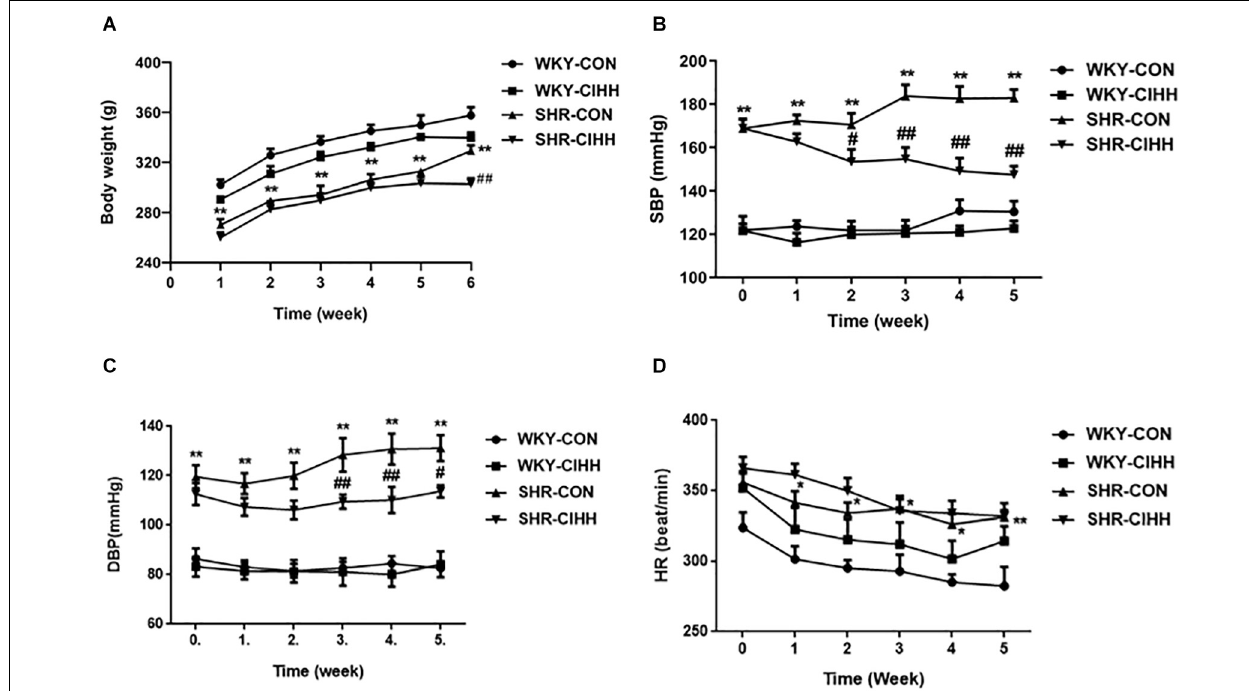
FIGURE 1 | Effect of chronic intermittent hypobaric hypoxia (CIHH) on body weight and arterial blood pressure in spontaneously hypertensive rat (SHR). (A) Body weight; (B) systolic blood pressure (SBP); (C) diastolic blood pressure (DBP); (D) heart rate (HR). Data are expressed as mean ± SEM; SHR-CON: control SHR ( n = 12); SHR-CIHH: SHR with CIHH ( n = 12); WKY-CON: control WKY rats ( n = 6); WKY-CIHH: WKY rats with CIHH ( n = 6); * P < 0.05, ** P < 0.01 vs. WKY-CON, # P < 0.05, ## P < 0.01 vs. SHR-CON (two-way